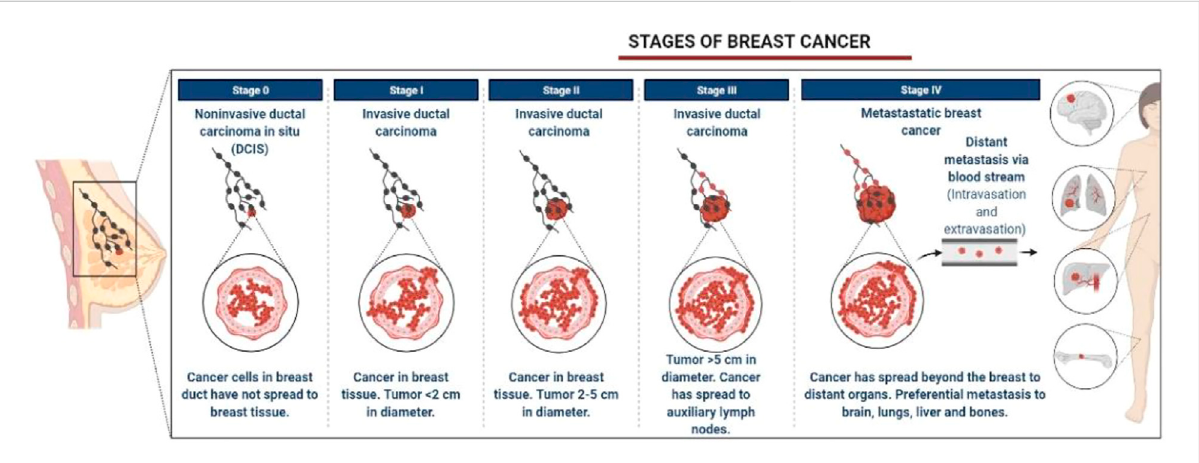
FIGURE 1 Various stages of breast